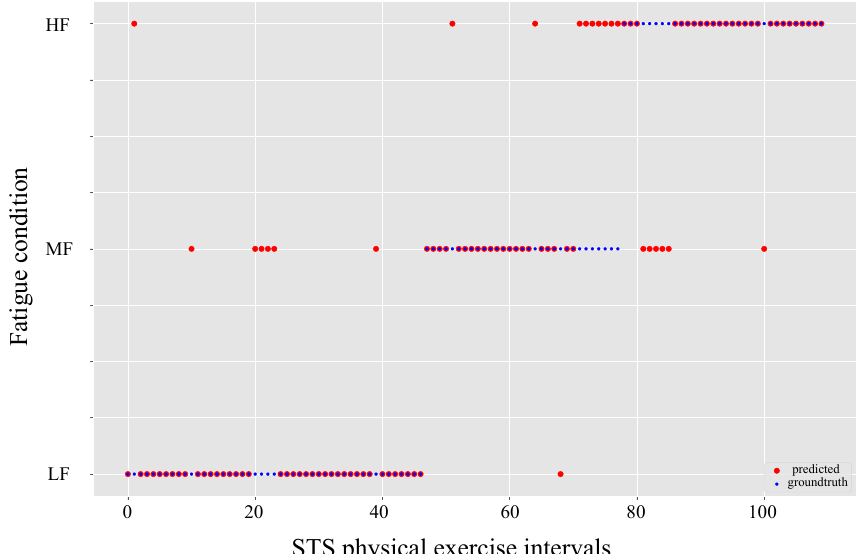
Figure 17. STS physical exercise intervals vs. fatigue conditions on the test set. The thinnest dots represent the ground-truth values, and the thickest dots are fatigue predictions.